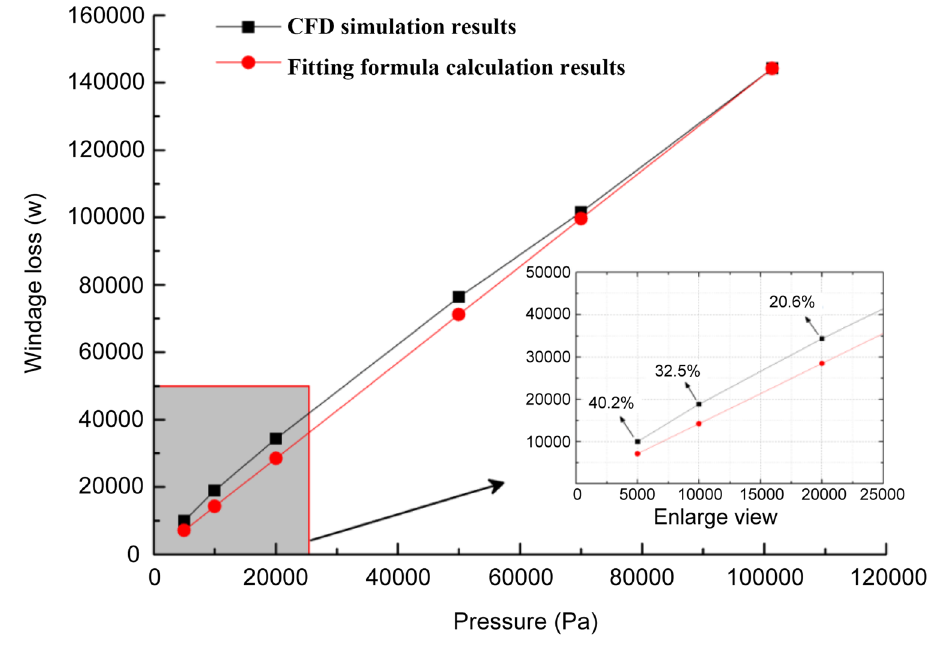
Fig. 15 Comparison of the simulated CFD windage losses and those calculated with the fitting formula